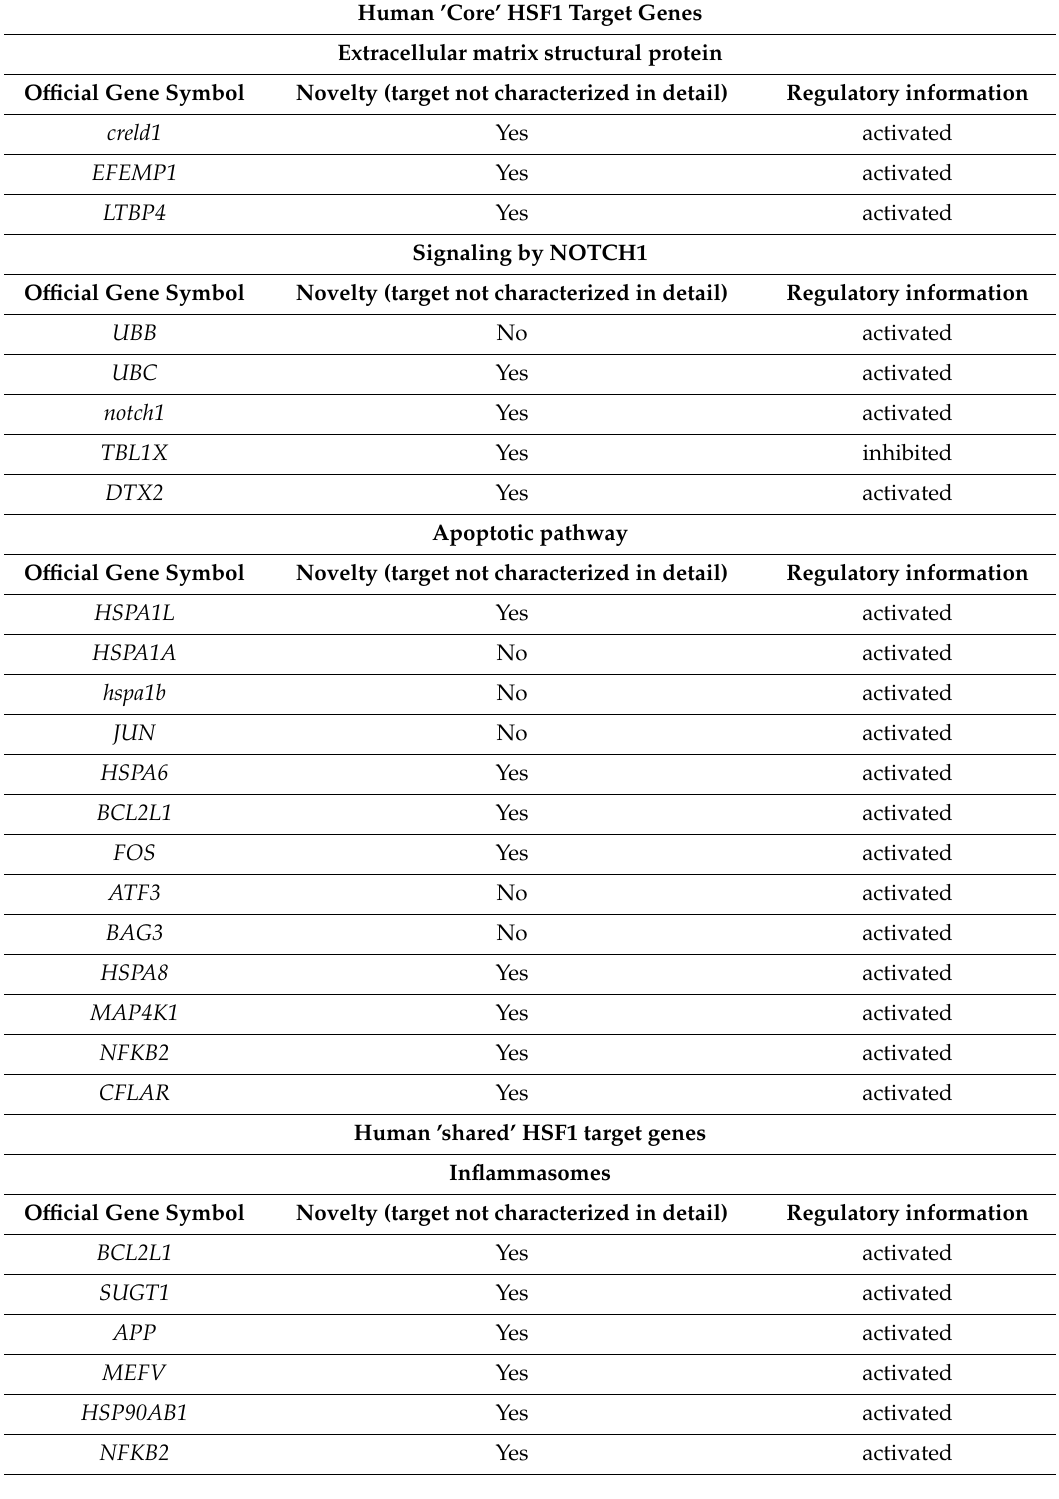
Table 2. Selected list of HSF1 target genes identified in human cell types, using the HSF1Base. Human ’Core’ HSF1 Target Genes Extracellular matrix structural